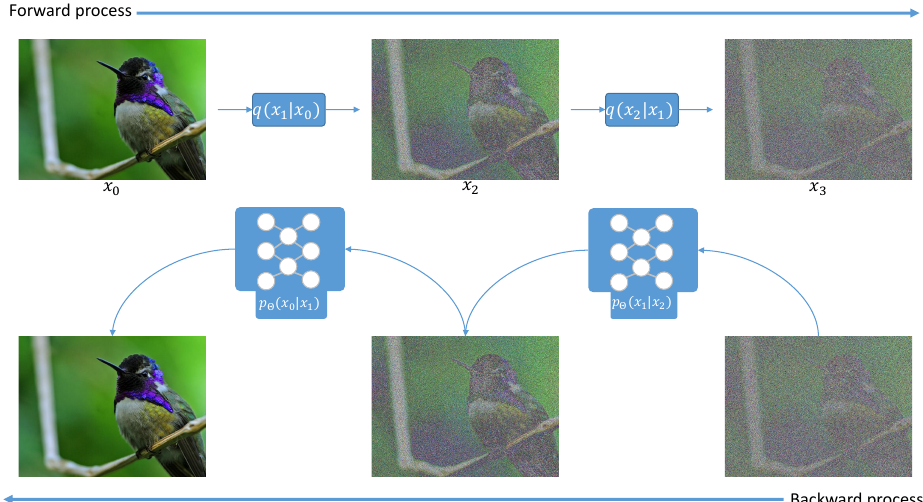
Figure 4. The diffusion process. Image taken from the Creative Commons website and has been released to the public domain by the